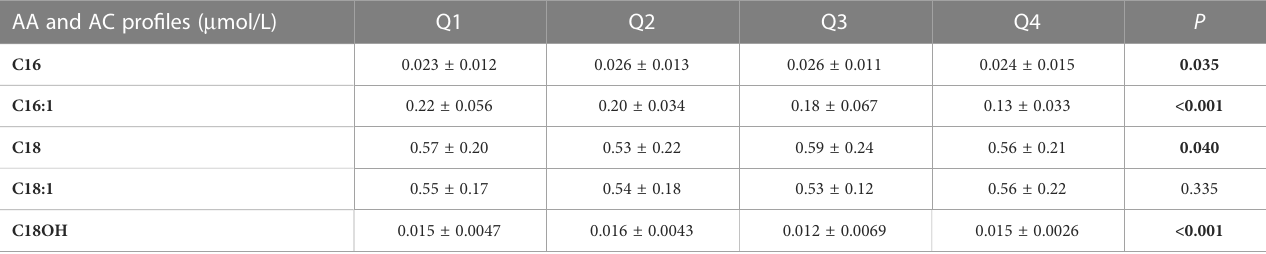
Bold values are presented as mean ± SD. FT4,freethyroxine;AA,aminoacid;AC,acylarnitine;ALA,alanine;ARG,arginine;GLY,glycine;LEU,leucine;ILE,isoleucine;MET,methionine;ORN,ornithine;PHE,phenylalanine;PRO,proline; SA, salicylic acid; TYR, tyrosine; VAL,